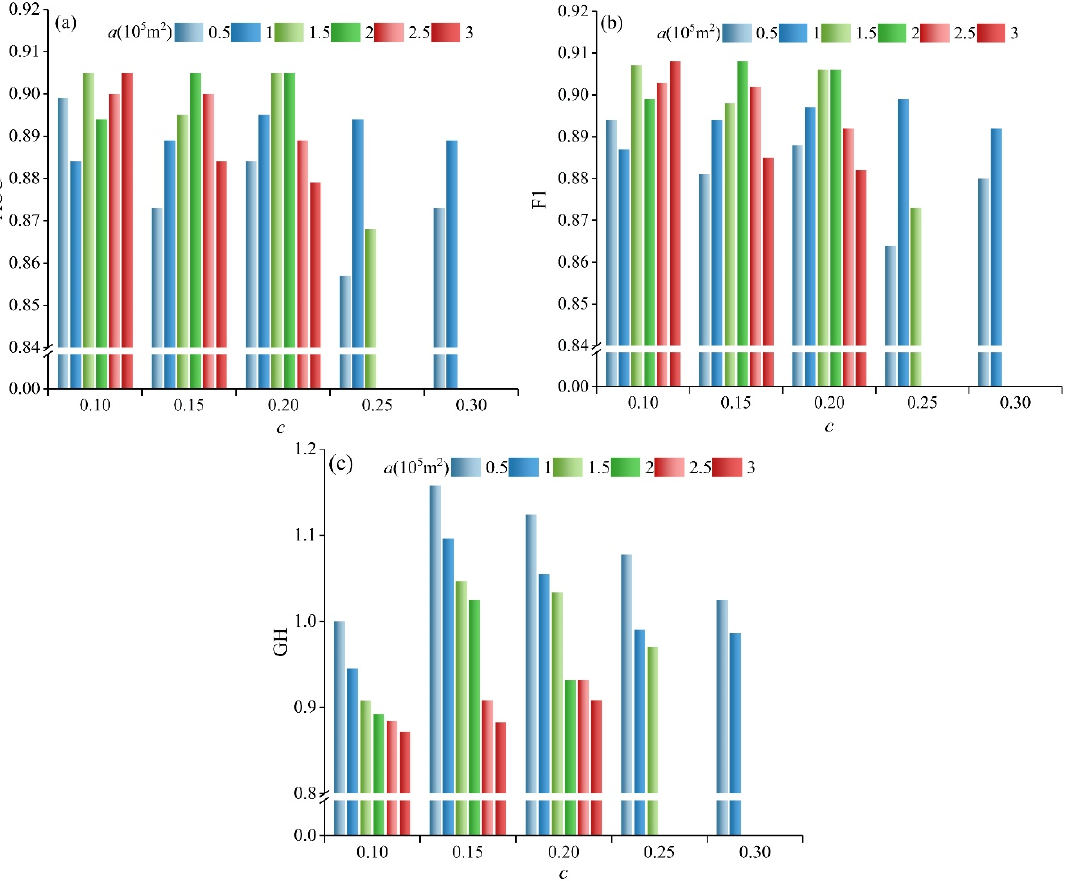
Figure 9. AUC, F1 and GH values under different slope units: ( a ) AUC, ( b ) F1 and ( c ) GH.